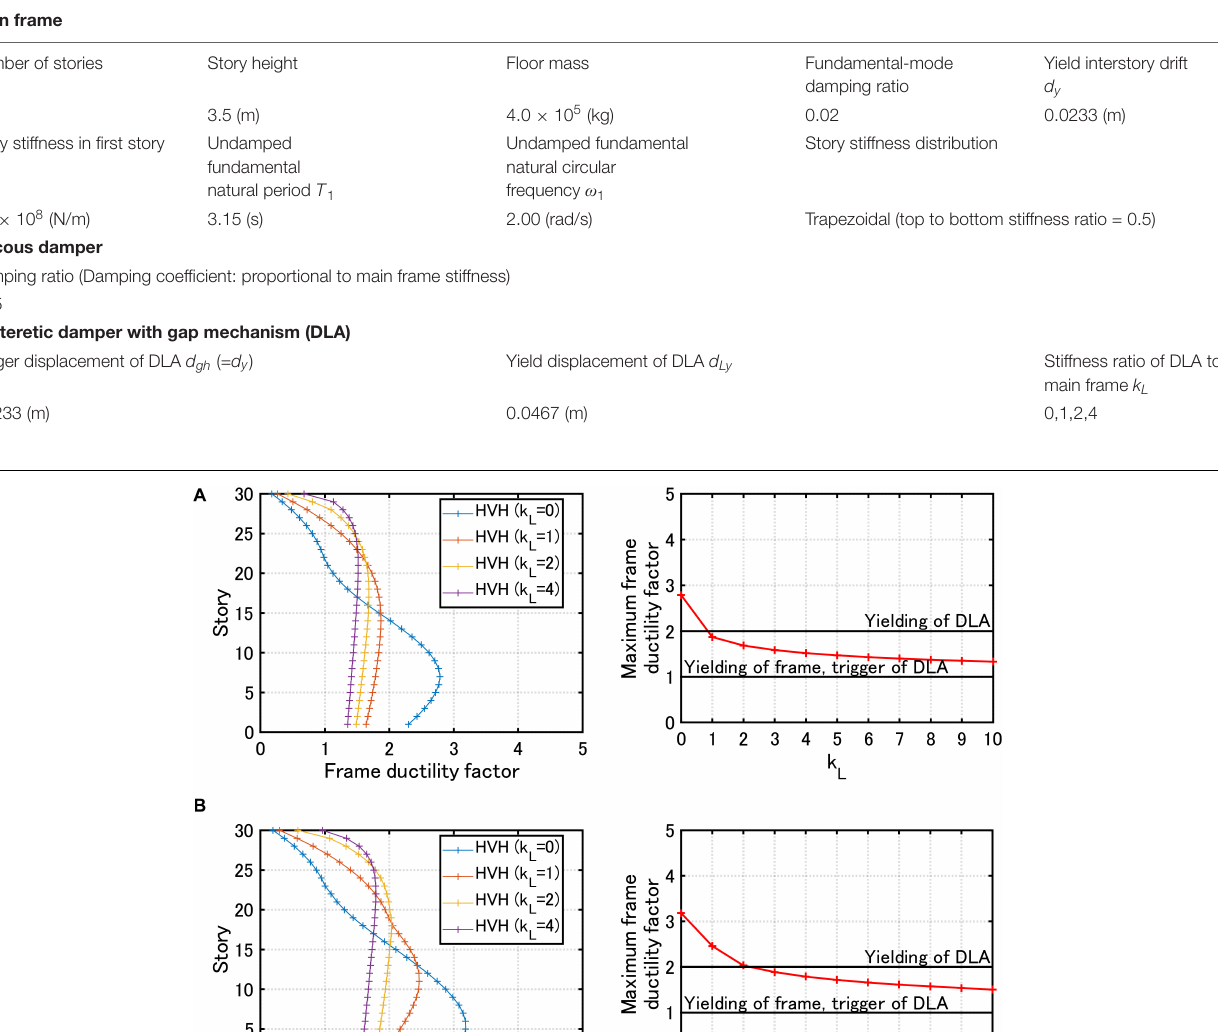
TABLE 1 | Structural parameters of main frame, viscous damper, and hysteretic damper (HVH system).